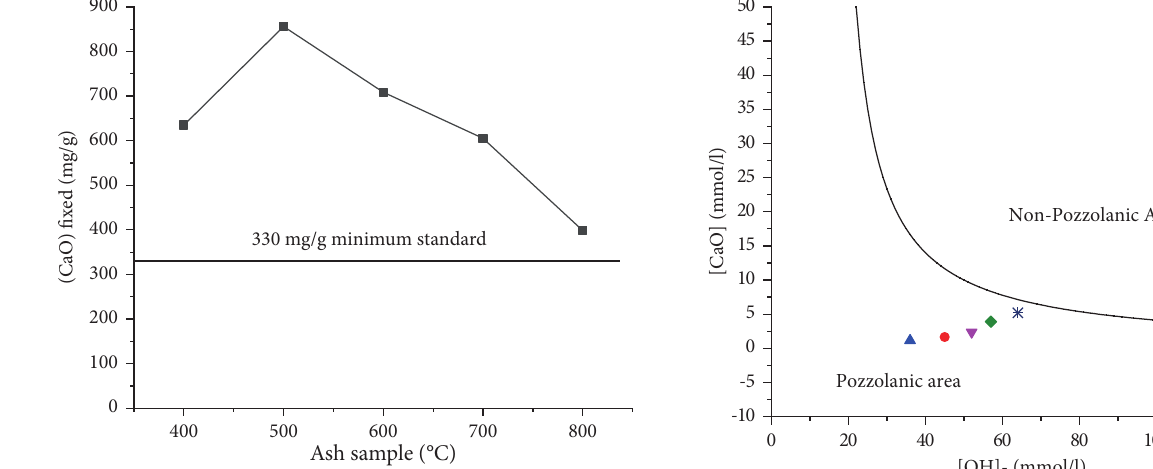
Figure 7: Chapelle activity at different temperatures.